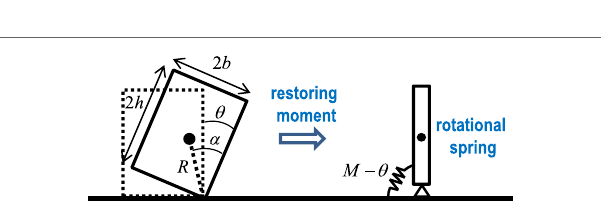
FigUre 3 | Modeling of rocking rigid block by rigid bar supported by non-linear elastic rotational spring with rigid initial stiffness and negative second slope .